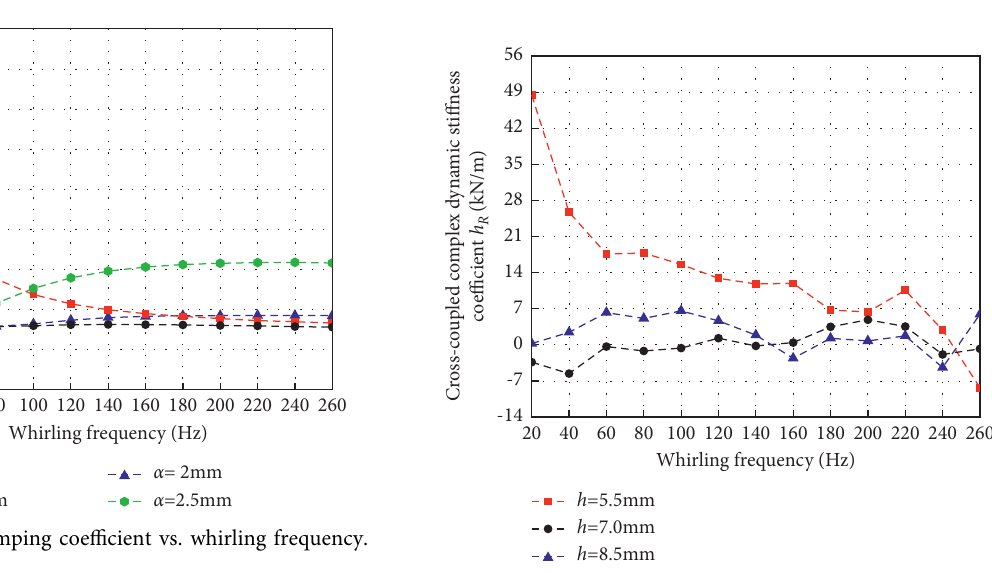
Figure 17: Cross-coupled complex dynamic stiffness coefficient vs. whirling